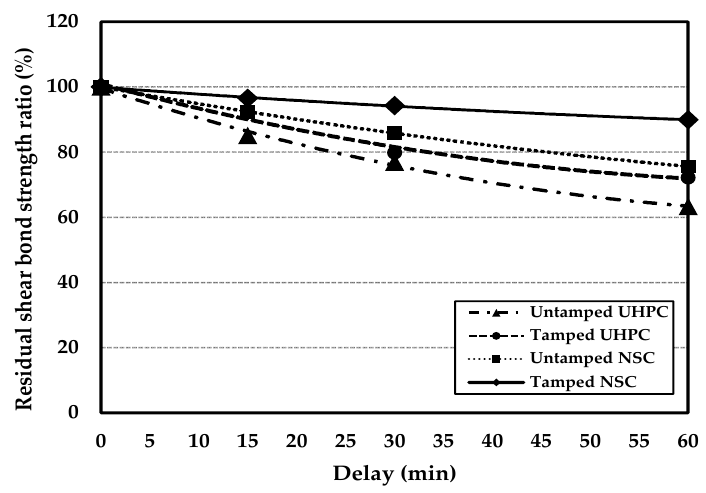
Figure 6. Comparison of ratios of decrease in the bonding shear strengths of NSC and UHPC with tamping and increasing delay.